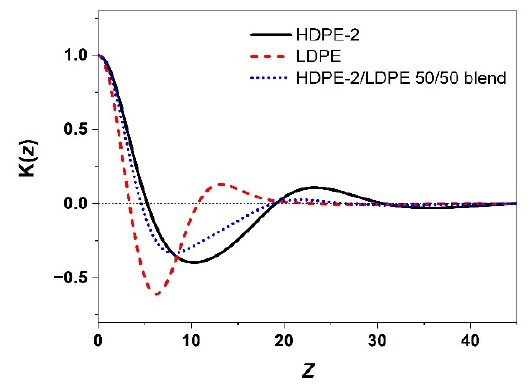
Figure 7. One-dimension correlation functions of the neat HDPE-2, neat LDPE, and the HDPE- 2/LDPE 50/50 blend. Table 5. Data of the long period ( L ), crystalline phase thickness ( L c ), and amorphous phase thickness ( L a ) obtained from the one-dimension correlation function.